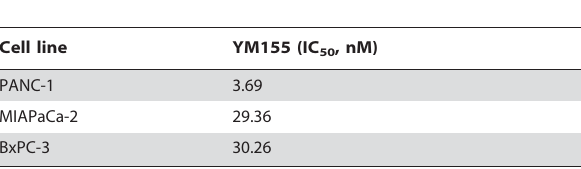
Table 1. YM155 IC 50 values in pancreatic cancer cell